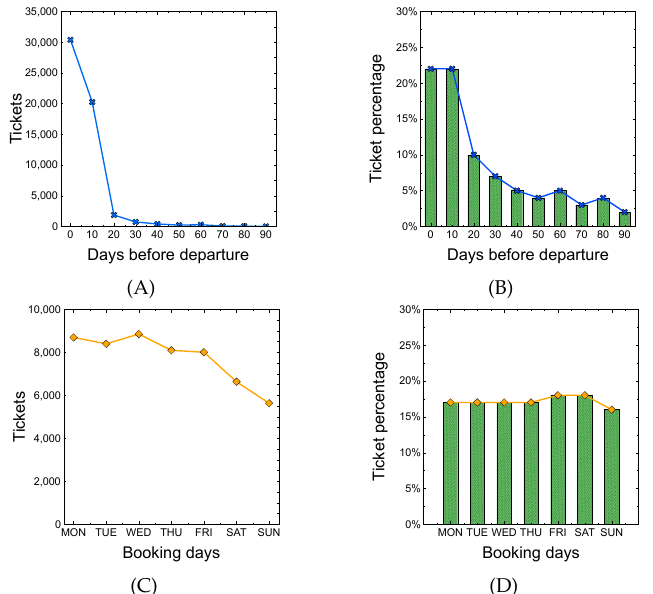
Figure 6. No. and percentage of purchased tickets considering the days before departure ( DBD ) and the booking day of the week ( BDOW